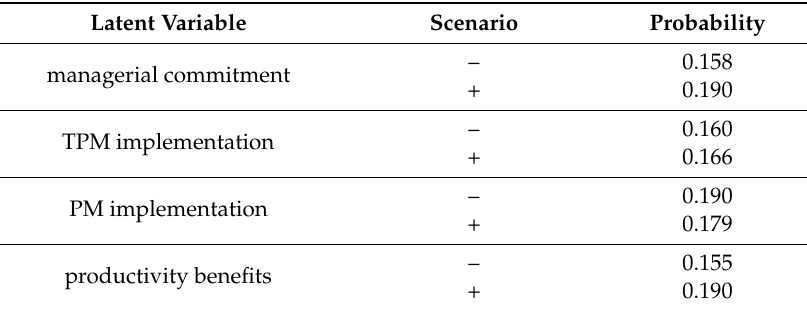
Table 9. Scenarios and probabilities of independent